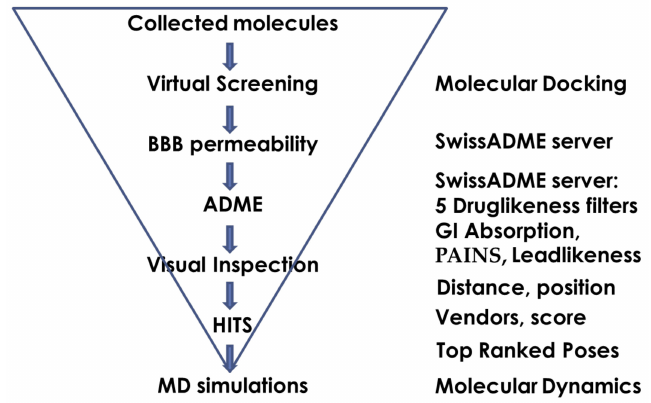
Figure 1. Hit selection by docking-based VS and ADME